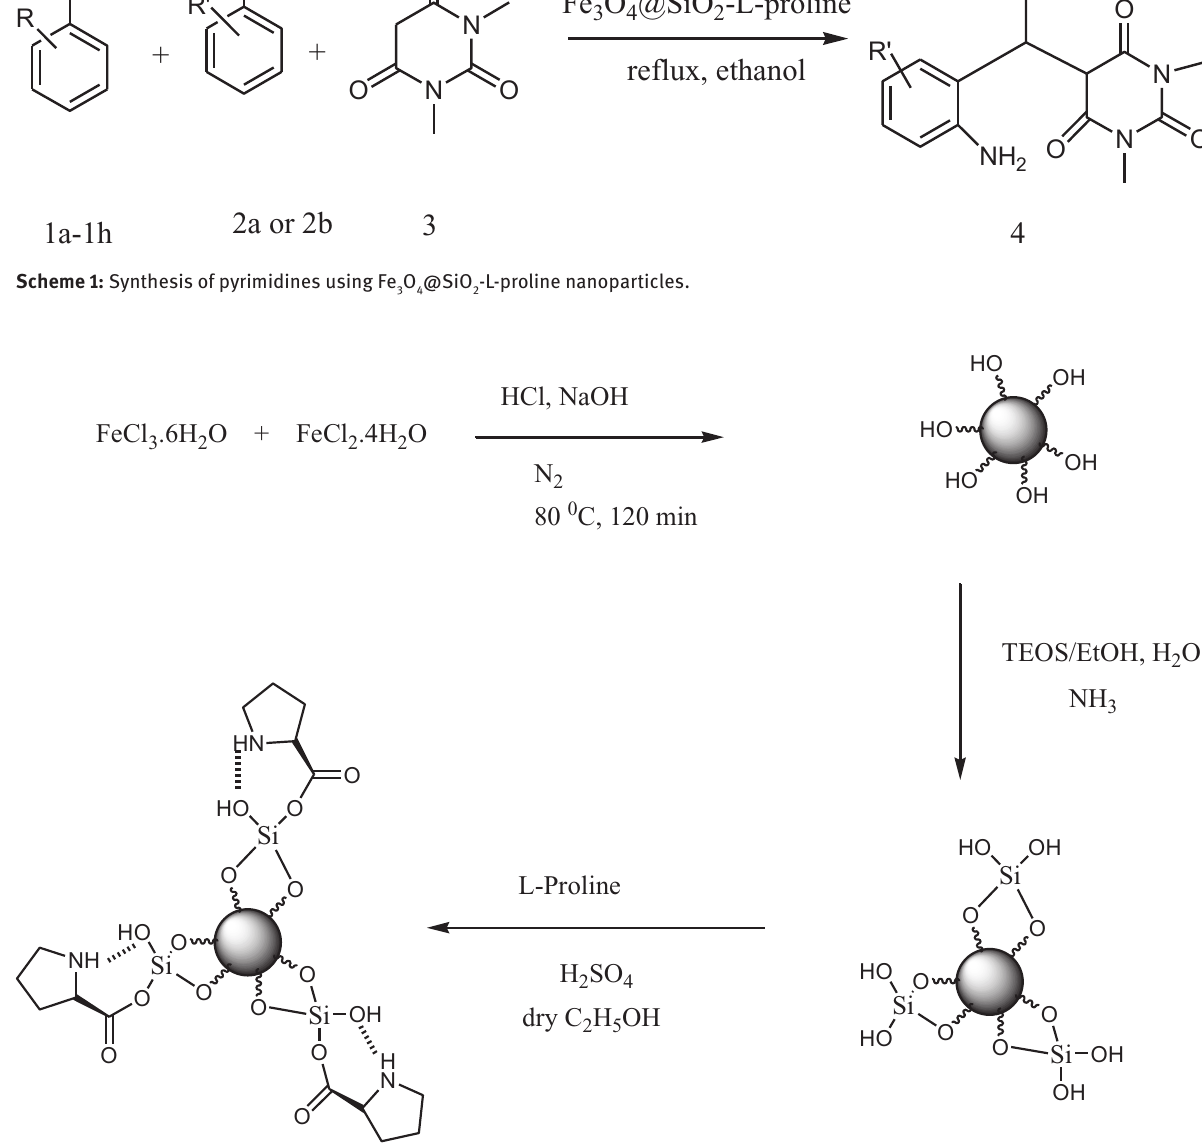
O @SiO -L-proline nanoparticles. 3 4 2